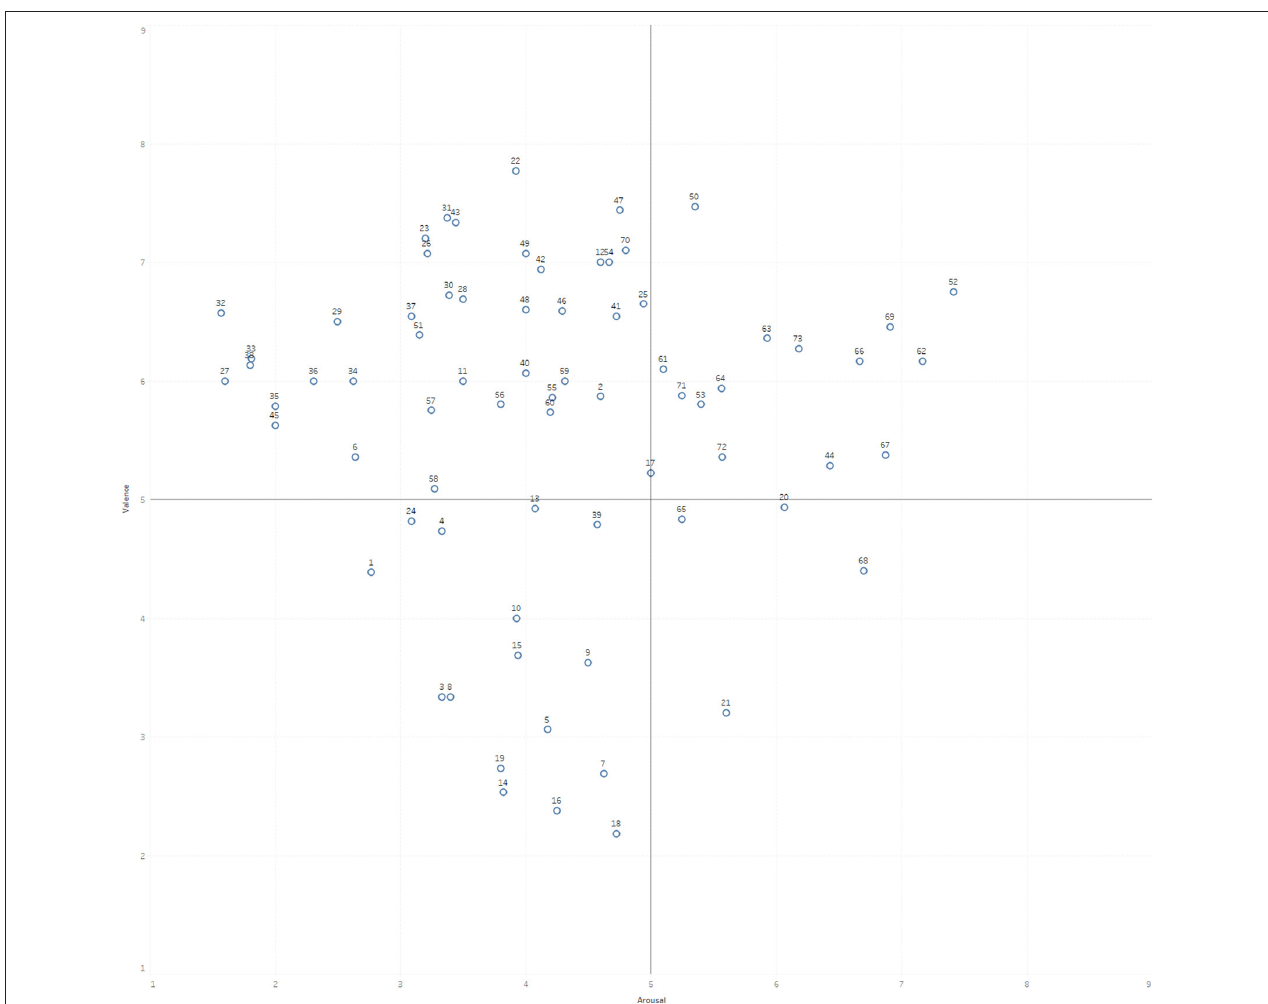
FIGURE 4 | Scatterplot of immnersive video clips defined by mean arousal and valence